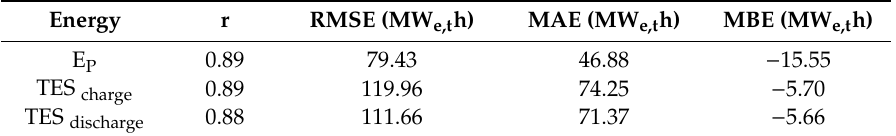
Table 2. Statistical analysis of the daily values (i.e., the sum of each 24-h values) of the estimated electric energy to the grid, E P (MW e h), and stored thermal energy, TES (MW t h) charge and discharge energies computed from measurements (obs) and forecasts (ecmwf). Hourly values of E P and TES correspond to one year of data (from 1 July, 2017 to 30 June, 2018) produced by a CR power plant with a configuration similar to the Gemasolar plant (Sevilla, Spain) simulated through the SAM. Daily statistical error metrics such as the correlation coe ffi cient (r), root mean square error (RMSE), mean absolute error (MAE), and mean bias error (MBE) are